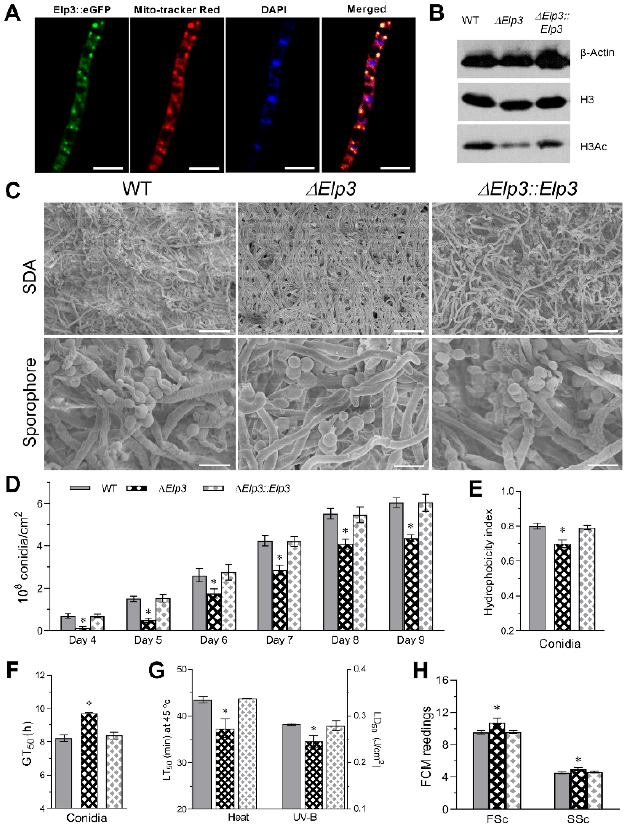
Figure 1. Characterization of B. bassiana Elp3: subcellular localization, histone acetyltransferase activity, and contribution to conidiation. ( A ) Representative images of cellular localization monitoring the BbElp3-GFP fusion protein. Scale bars: 10 μ m. Hyphal cells were harvested from 3 d SDB cultures and costained with the mitochondria-specific dye (Mito-tracker Red) and nuclei-specific dye (DAPI). ( B ) Western blot analyses of histone H3 acetylation. ( C ) Scanning electron microscopy (SEM) images of aerial hyphae and sporophore of cells harvested from SDAY plats grown for 4 d. Scale bars: upper panels, 20 μ m; lower panels, 5 μ m. ( D ) Conidial yields assessed for each strain over a 9 d time course of growth on SDAY plates. ( E ) Conidial hydrophobicity indexes. ( F , G ) Conidial germination times (GT50) and conidial tolerances to heat stress and UV-B irradiation determined as detailed in the Methods section. ( H ) FACS analysis for cell size (FSc) and density (SSc) of aerial conidia grown for 7 d on SDAY. Asterisk indicates significant difference ( p < 0.05) from unmarked (Tukey’s HSD). Error bars: SD from three technical replicates.